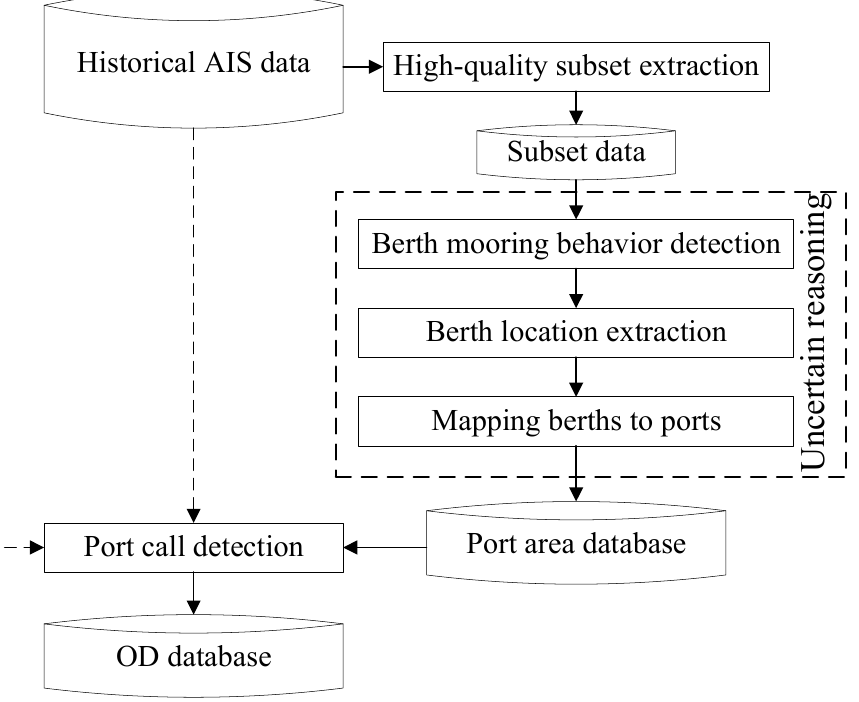
Figure 2. Overall framework for identifying port arrivals and departures from historical or real-time trajectory data.